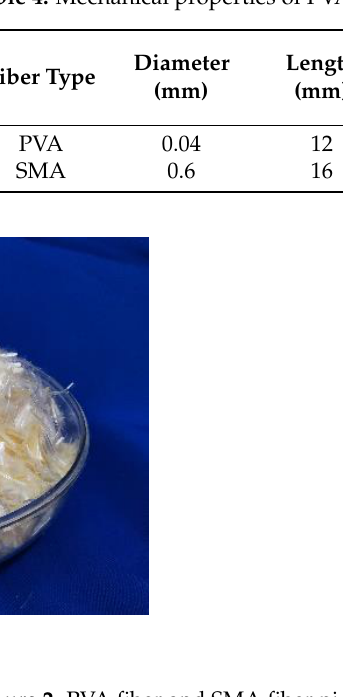
Table 4. Mechanical properties of PVA and SMA fiber.